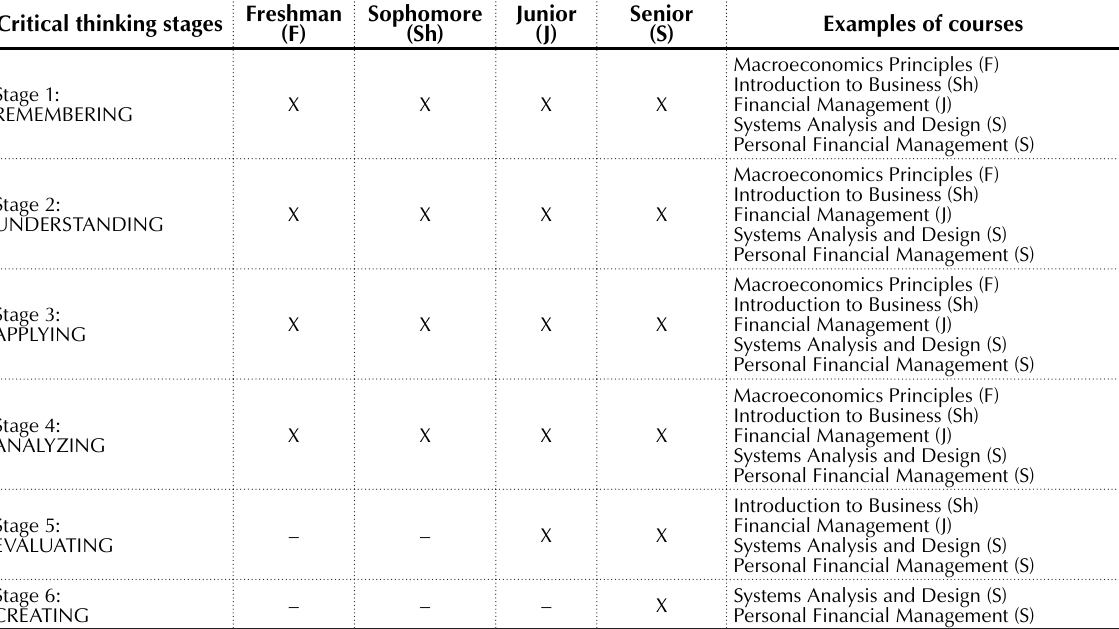
Table 3. Management Department critical thinking development by stages and